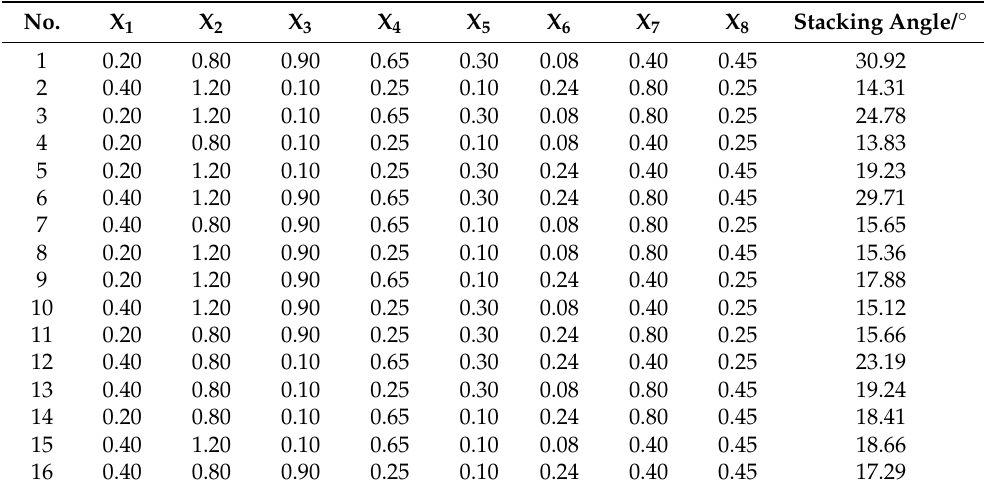
Table 4. Regular Two-Level Factorial Design and Experiment